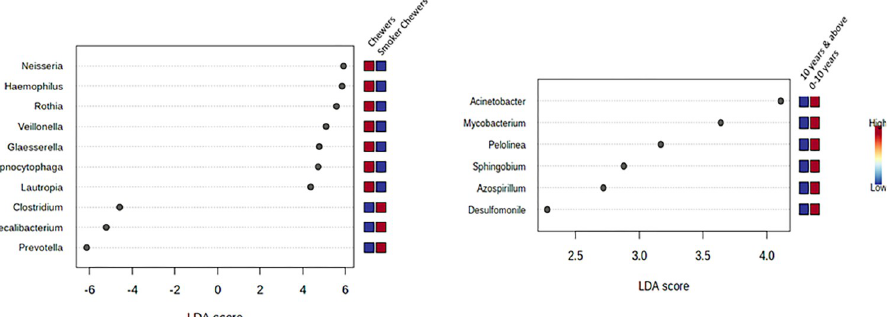
Fig 9. a. Lefse Plots: Genus-level oral microbiome significant features composition of Betel Quid chewer Vs. Smoker Chewers; b . Betel Quid Chewer (Chewing History).